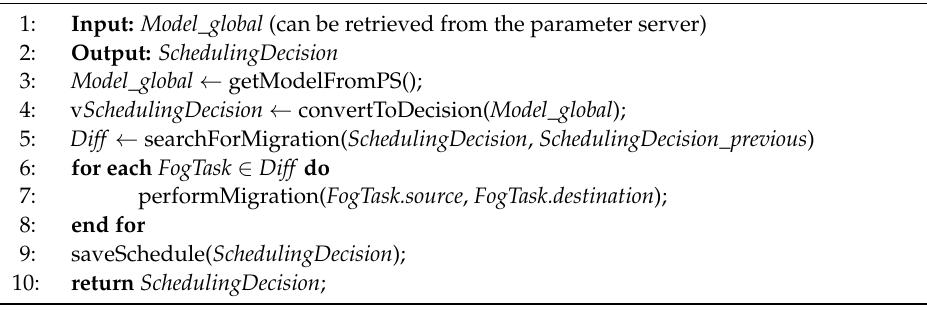
Algorithm 3. Scheduling